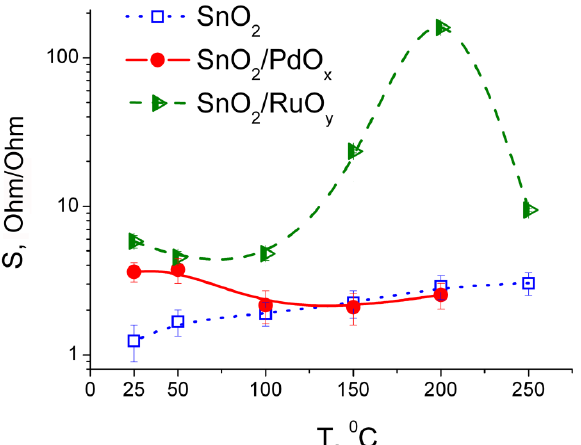
Figure 6. Temperature dependence of sensor signals of nanocrystalline SnO 2 , SnO 2 /PdO x , and SnO 2 /RuO y samples to 50 ppm NH 3